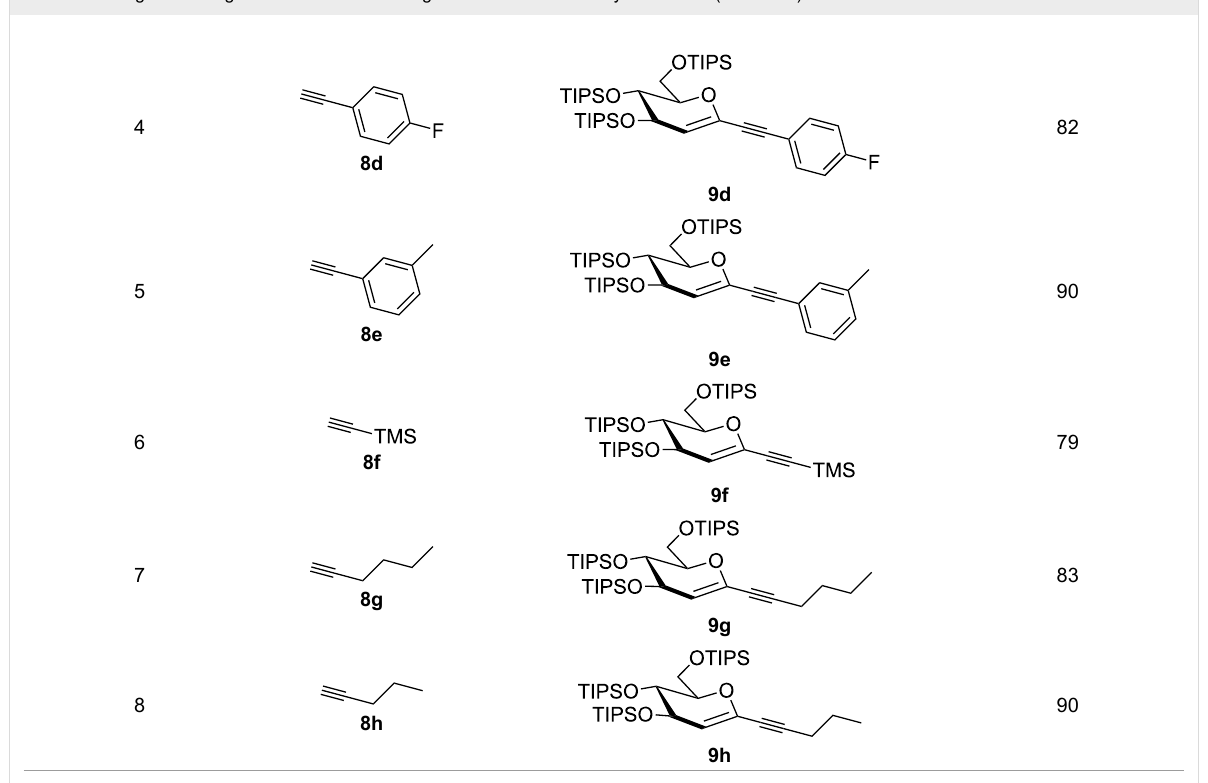
Table 1: Sonogashira–Hagihara reactions of 1-iodoglucal 7 with different alkynes 8a – 8h .